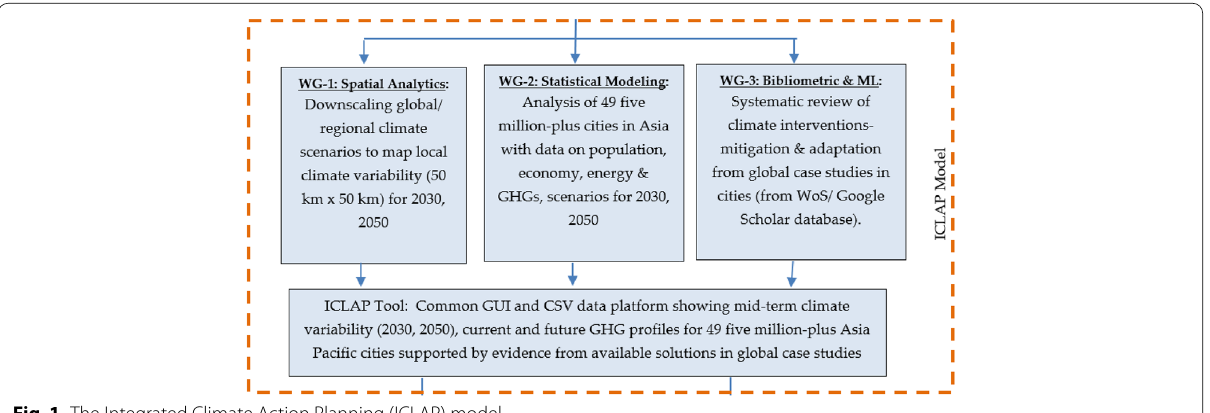
Fig. 1 The Integrated Climate Action Planning (ICLAP)